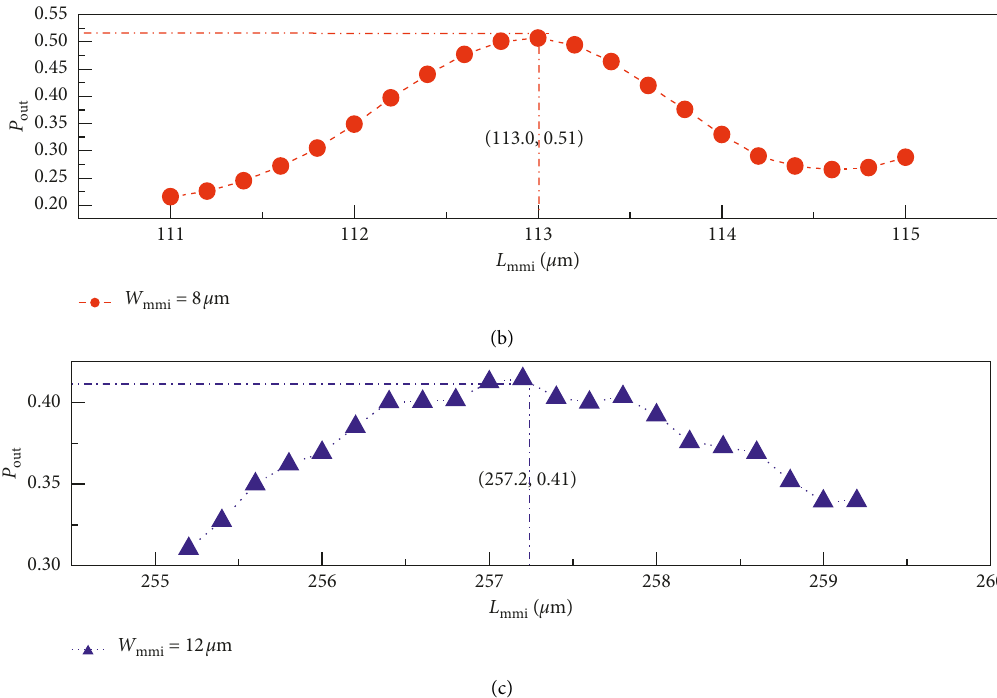
Figure 3: (a) The maximum output power is 0.62 at MMI length L power is 0.51 at L mmi � 113.0 μ m and W mmi � 8 μ m. (c) Maximum output power is 0.41 at L mmi � 257.2 μ m and W mmi � 12 μ m.